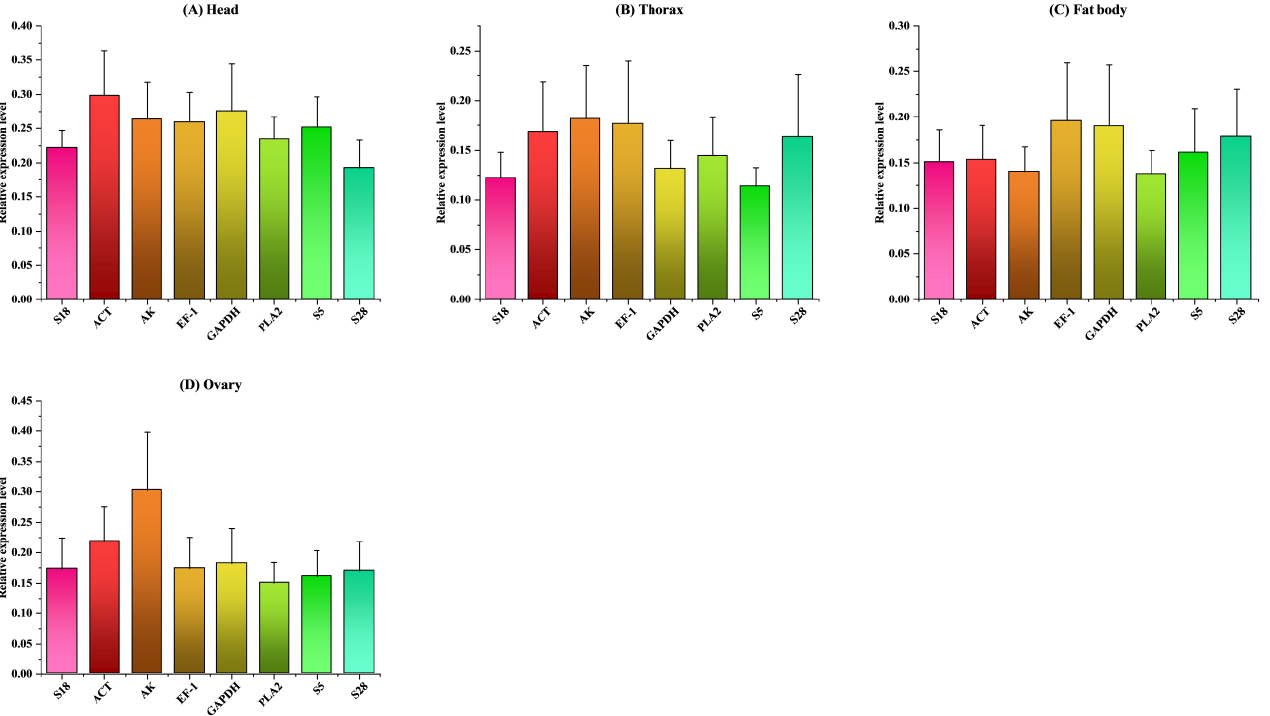
Figure 7. Changes in the levels of expression of the candidate reference genes in a variety of tissues and reproductive organs samples of B. terrestris. (( A ) head, ( B ) thorax, ( C ) fat body, ( D ) ovary)), The levels of gene expression in the bumble bee samples were compared to the Ct values of Vg, an internal target gene, in order to achieve a normalized reading. The values of the relative mRNA expression that were determined through the use of the 2 − ∆∆ Ct method are depicted in the graphs. Comparing the groups at a significance level of 0.05 required the use of a one-way analysis of variance (ANOVA), followed by multiple comparisons using post hoc analysis. The data are presented with the mean ±